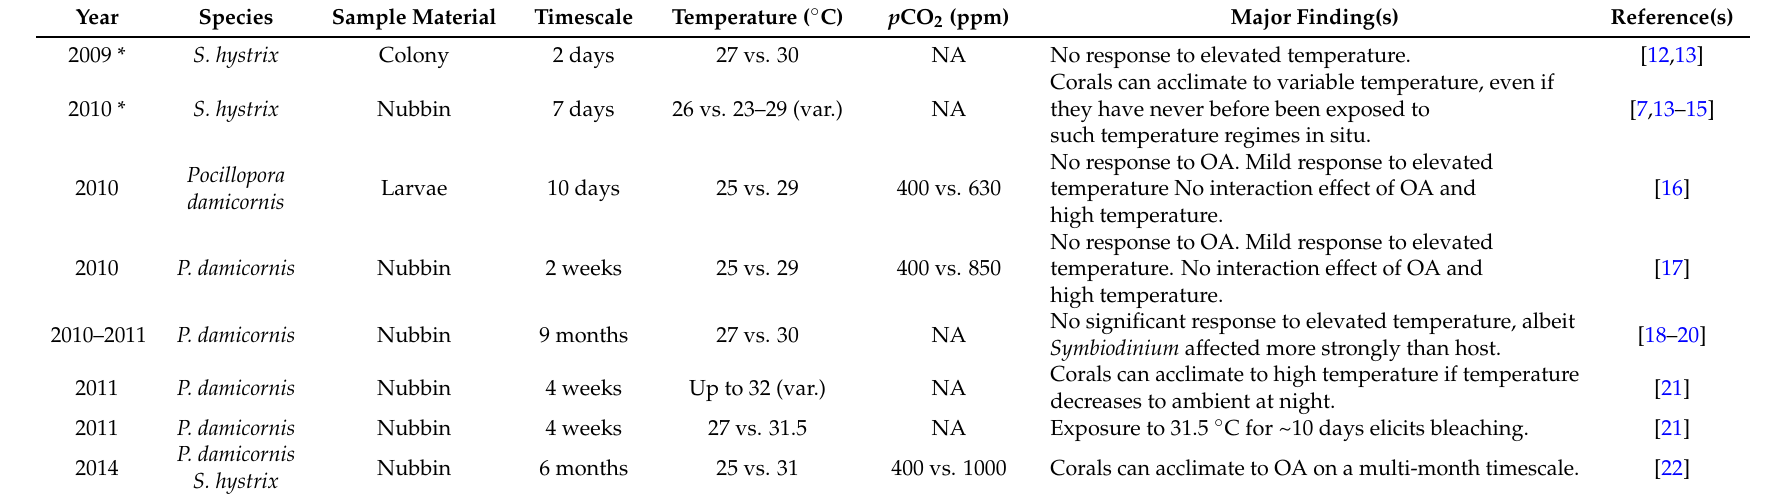
Table 1. Summary of eight environmental challenge studies performed at Taiwan’s National Museum of Marine Biology and Aquarium between 2009 and 2014. In general, only corals exposed to 31.5 ◦ C for 2–4 weeks were found to bleach, die, and/or, more generally, display a significantly different phenotype. p CO 2 = carbon dioxide partial pressure. ppm = parts per million. NA = not applicable. var. = variable. OA = ocean